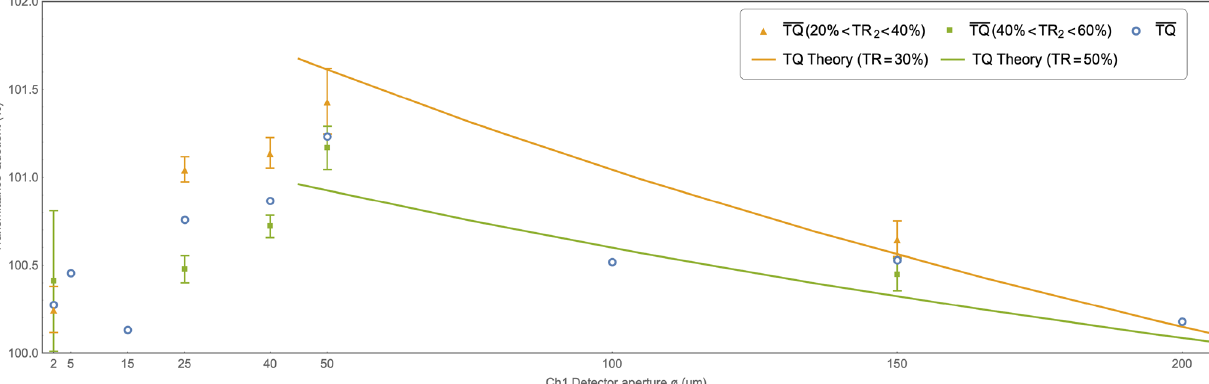
Figure 8. A comparison of the experiment results with exemplary predictions of the model taking into account the basic pressure dependence. Solid lines represent exemplary predictions of the model in a range of “geometric optics” approximation (see text) for two different pressures (expressed as 30% and 50% transmittances). The measured transmittance quotients TQ averaged for two distinct TR 2 transmittances ranges (20–40% and 40–60% respectively) are presented with 1 σ standard error bars. The 5-, 15- and 100 µ m apertures are omitted due to missing data in this range of pressures. The transmittance quotients averaged for all pressures for all apertures are superimposed for convenience (blue circles without error